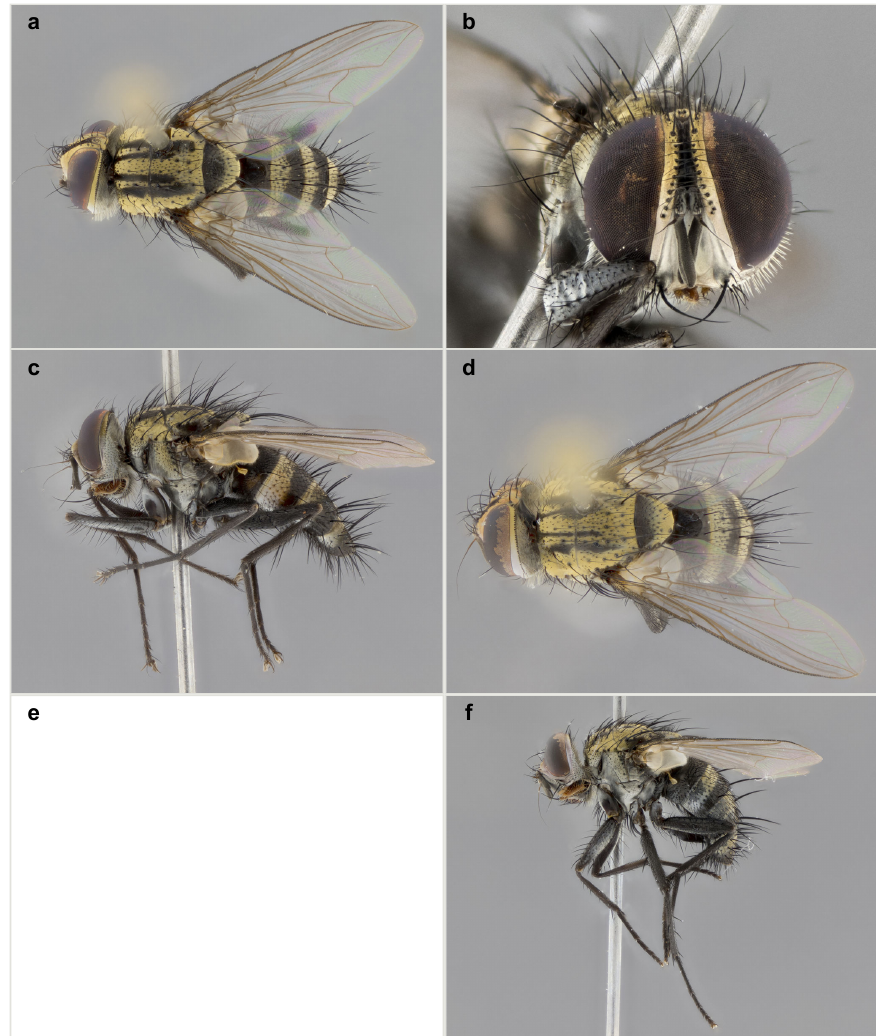
General morphology of Calolydella fredriksjobergi sp. n. ; a–c : male holotype, voucher